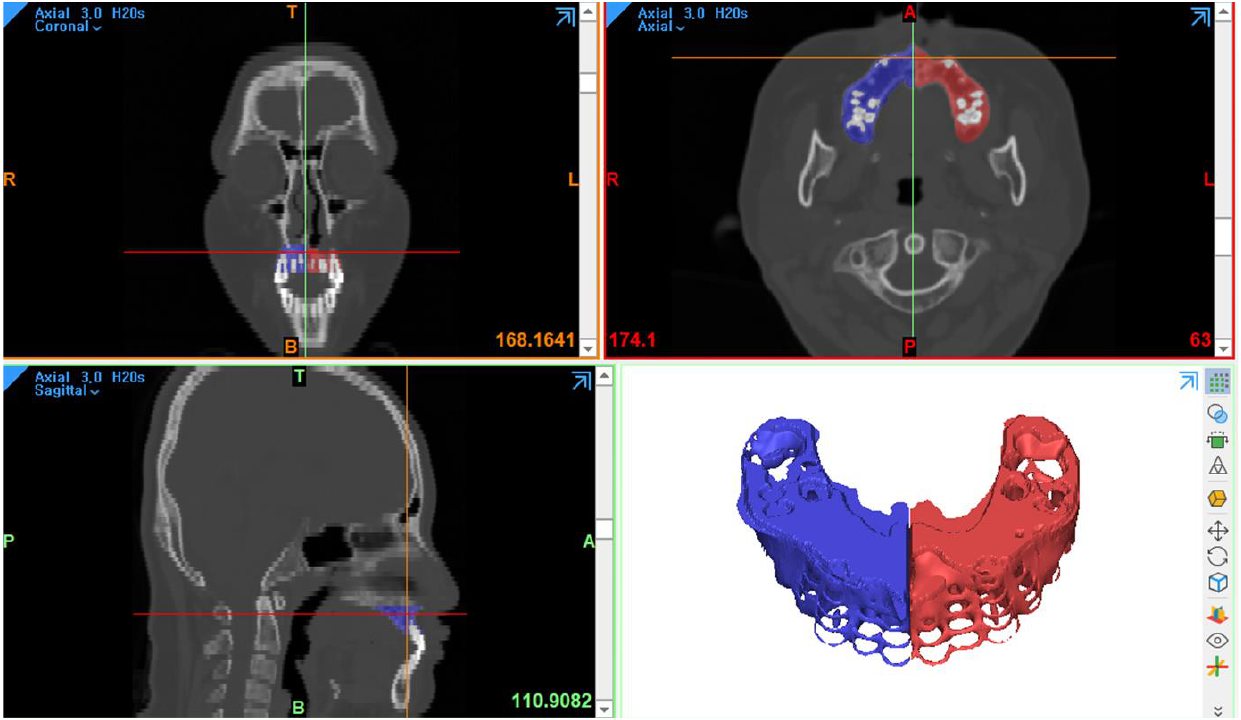
Figure 2. Volumetric analysis using Mimics and 3-Matics software. The conjugate of axial images of computed tomography scans is converted to a three-dimensional structure. Then, the volumes of the cleft side (red) and normal side (blue) are calculated automatically by the software.